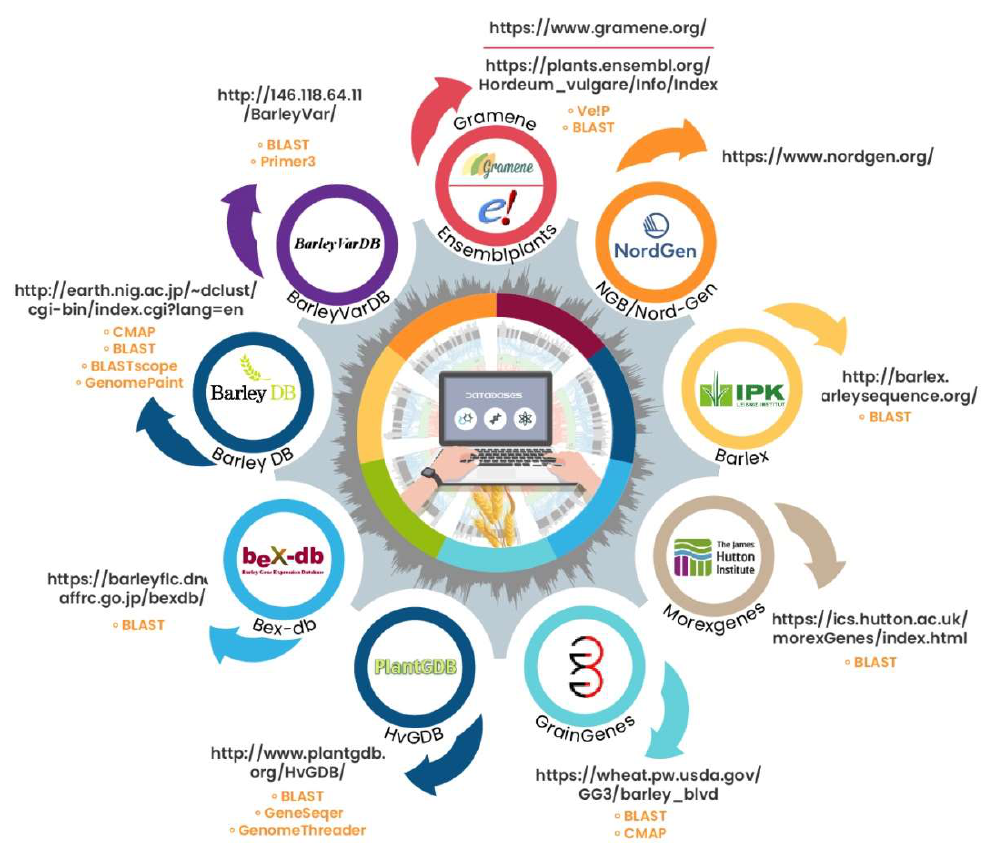
Figure 1. Compilation of quick and short information on the major barley genome databases. Each small, colored circle introduces a different database (name under each circle), with the arrows pointing to the addresses of their webpages. The yellow-colored text under the webpage links shows the names of the tools offered in that database.